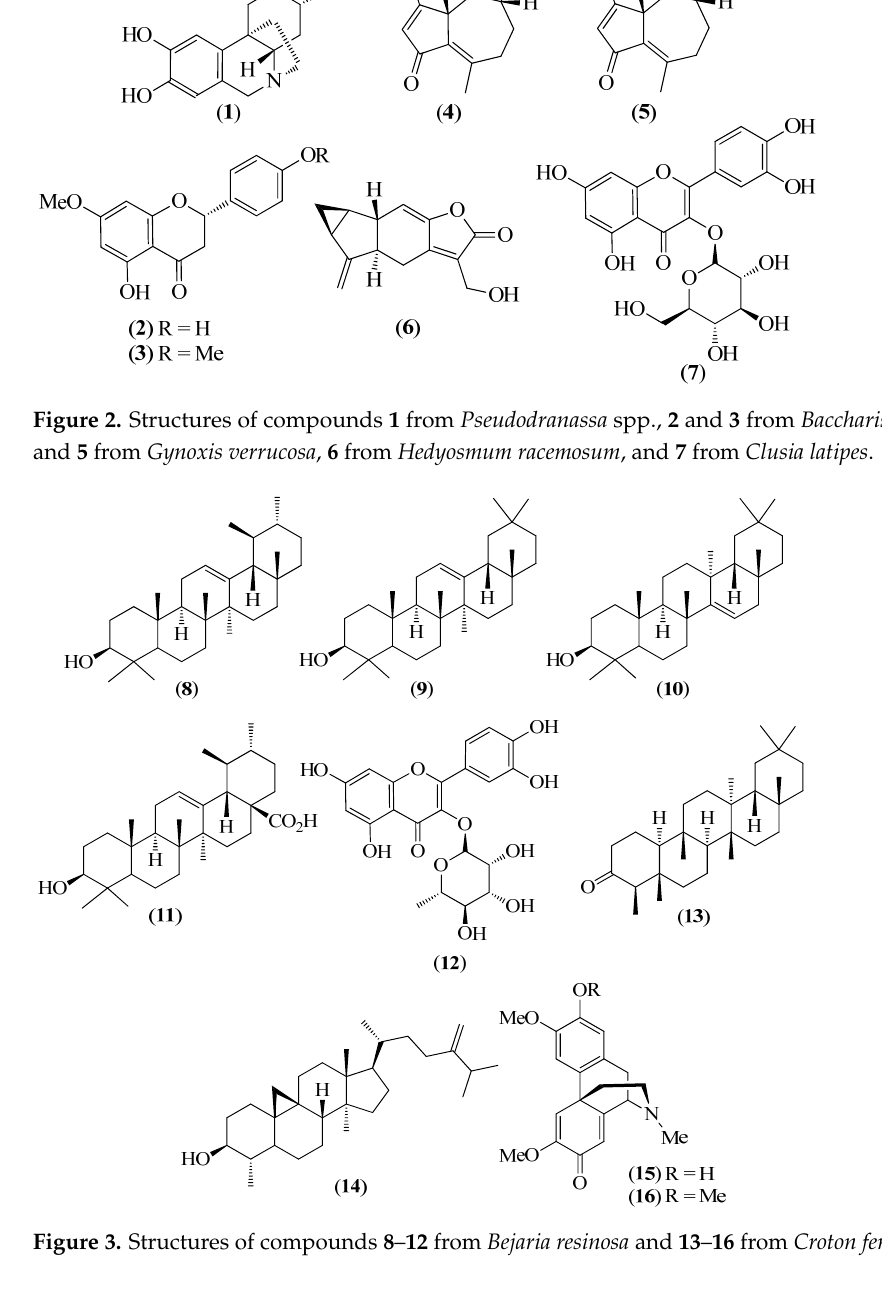
Figure 4. Structures of compounds 17 – 23 from Croton thurifer .